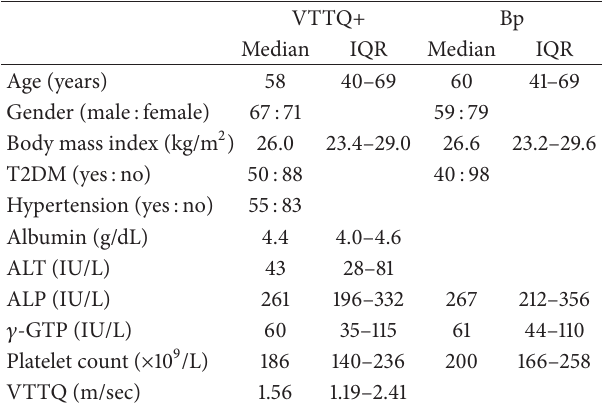
Table 1: Background